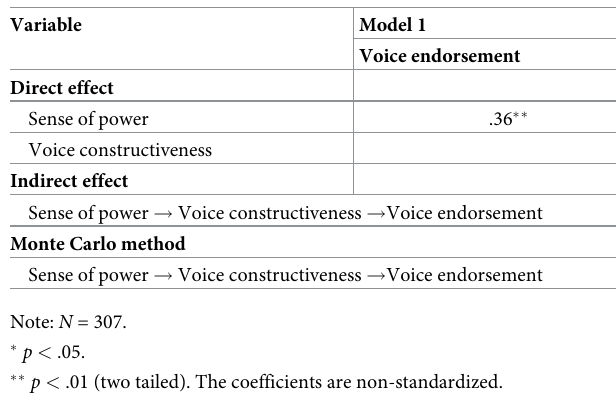
Table 2. Direct effect and indirect effect